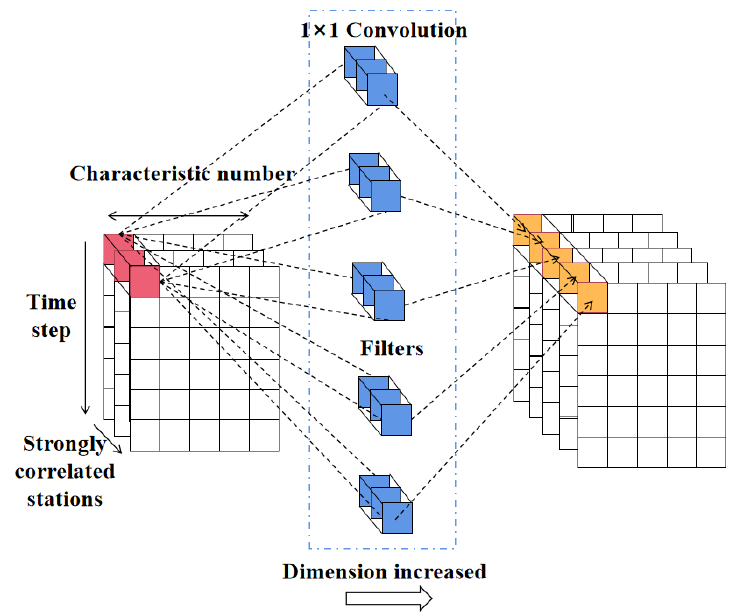
Figure 2. Uses 1 × 1 convolution kernel to raise the dimension of the eigenmatrix. Figure 2. Uses 1×1 convolution kernel to raise the dimension of the eigenmatrix. The following dimension reduction process of eigen matrix is based on spatial attention The following dimension reduction process of eigen matrix is based on spatial mechanism, as shown in Figure attention mechanism, as shown in Figure 3.